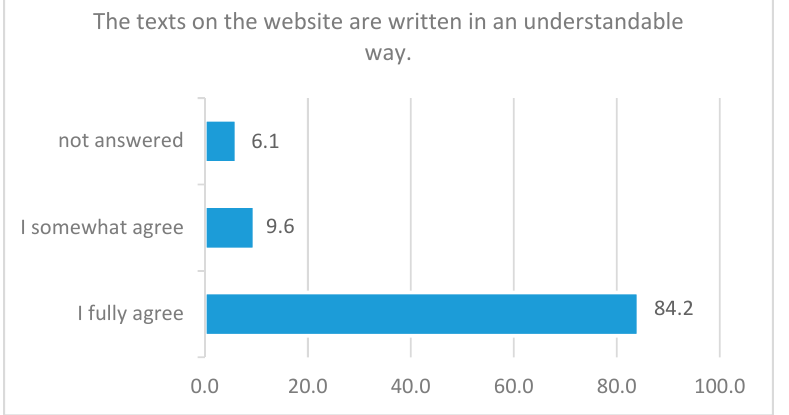
Figure 4. Response rate to the statement “The texts on the website are written in an understandable way”, in percent, N = 114.